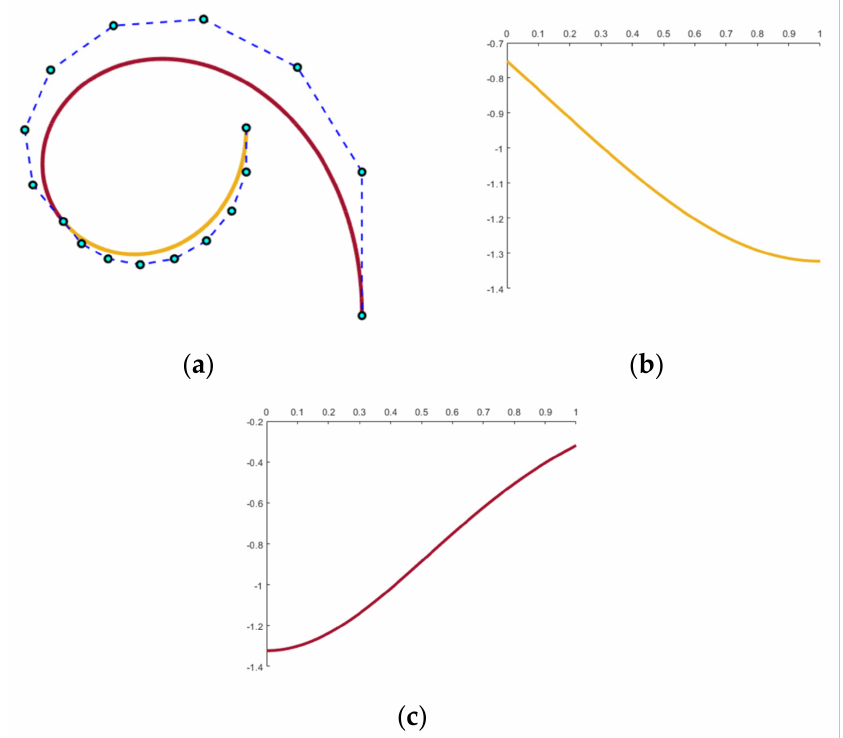
Figure 12. Results under subdivision. ( a ) Two typical curve segments join at t ∗ ; ( b ) first segment has decreasing curvature variation; ( c ) second segment has increasing curvature